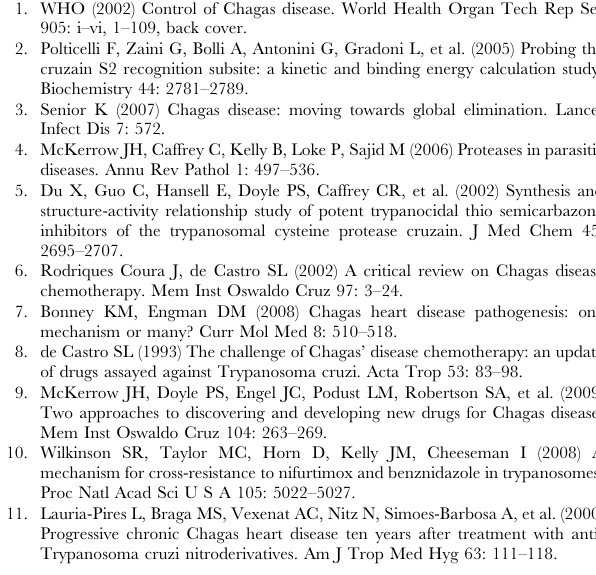
Figure S1 The alignment of selected peptidase C1 family members. Found at: doi:10.1371/journal.pntd.0000676.s001 (0.18 MB